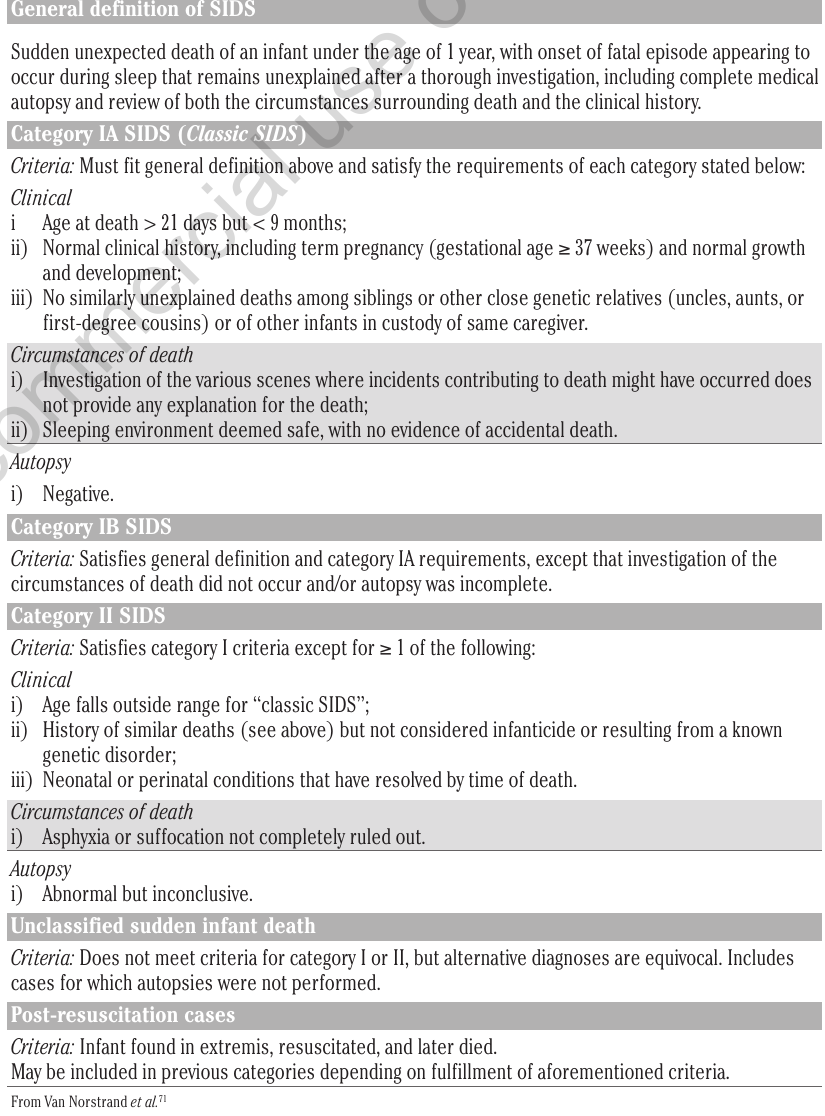
Table 1. Classifications of sudden infant death syndrome (SIDS). General definition of